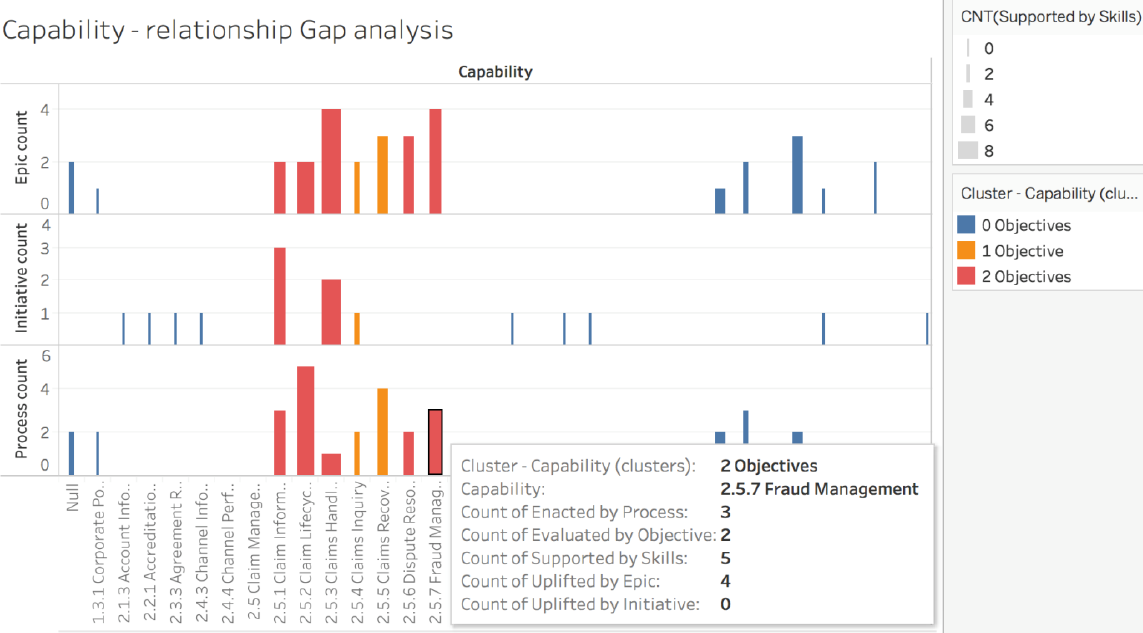
Figure 10. Capability relationship